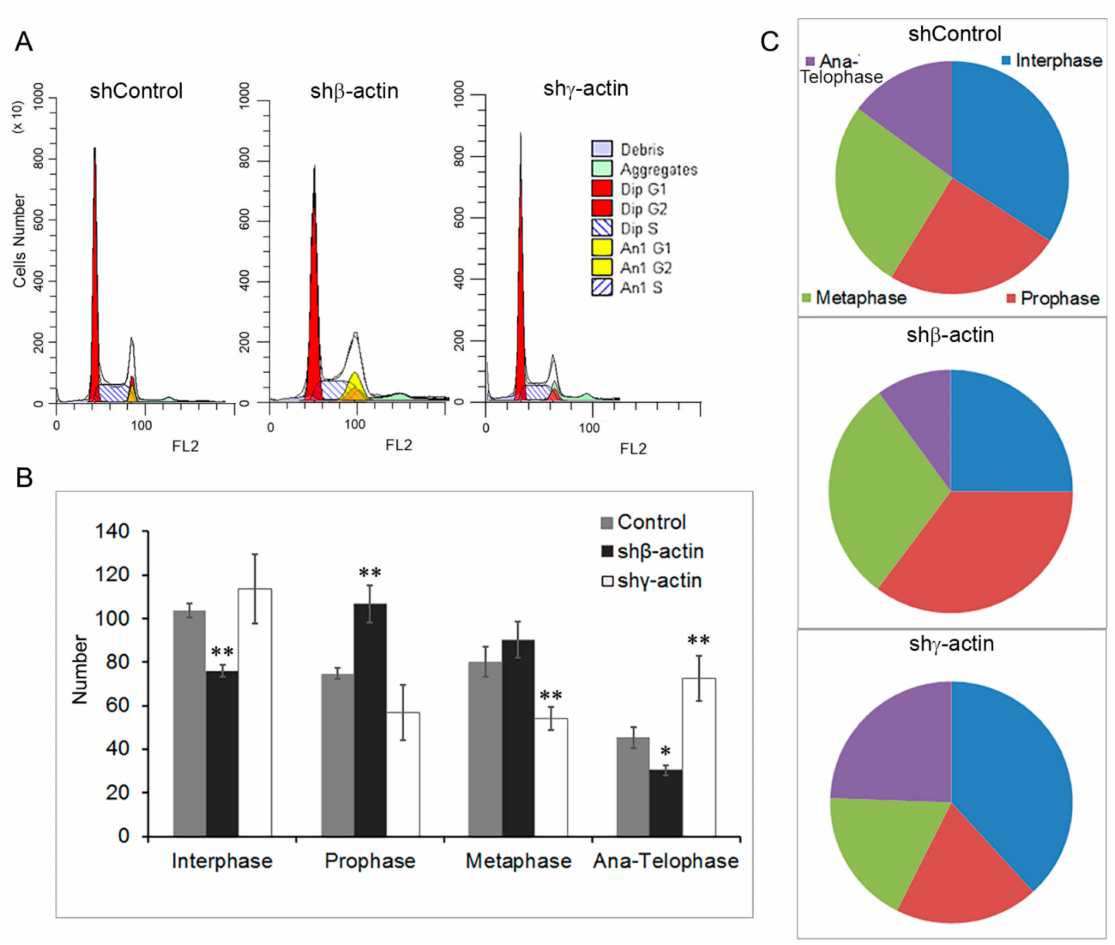
Figure 2. Downregulation of β - or γ -actin expression by corresponding shRNAs in MDA-MB-231 breast cancer cells leads to cell cycle changes. ( A ). After 6d of β - or γ -actin depletion by corresponding shRNAs MDA-MB-231 cells were stained with propidium iodide. High content analysis of cell cycle distributions of flow cytometric data was performed after 6d of β - or γ -actin depletion by corresponding shRNAs in MDA-MB-231 cells. ( B ). The effects of β - or γ -actin depletion on quantitative ratio of cells in interphase and different mitotic phases were analyzed by IF cytometry. The Y -axis indicates the number of cells in specific phases. Student’s t -test, n = 3. Values of p < 0.01 (**), and p < 0.05 (*) were considered as statistically significant. ( C ). The effects of β - or γ -actin depletion on mitotic phases were analyzed by IF cytometry. The pie chart shows the proportion of cells in different phases of